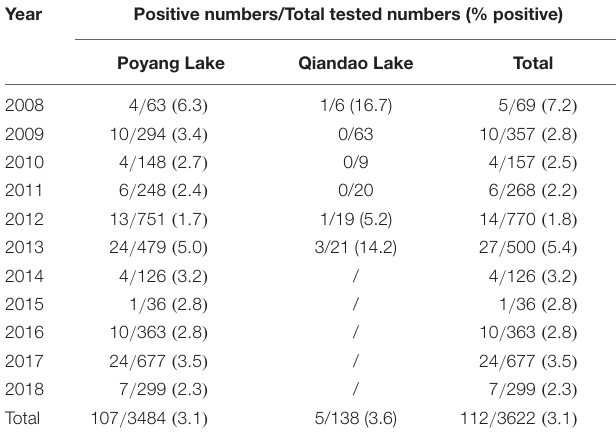
TABLE 1 | Rabies virus detection in ferret badgers in Poyang and Qiandao lake regions,